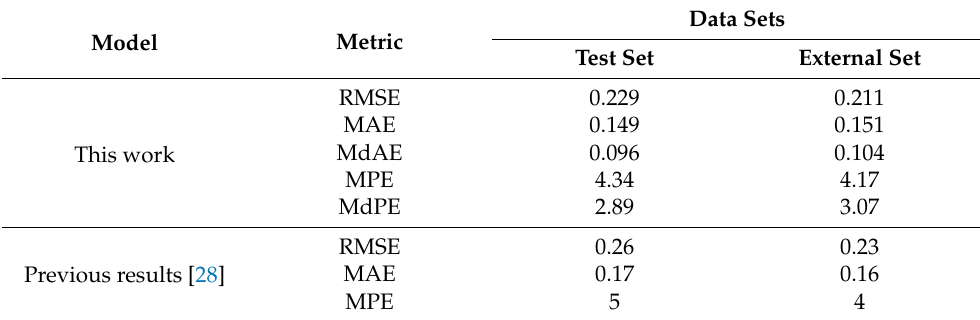
Table 4. The accuracy of retention index prediction for second dimension retention times a .